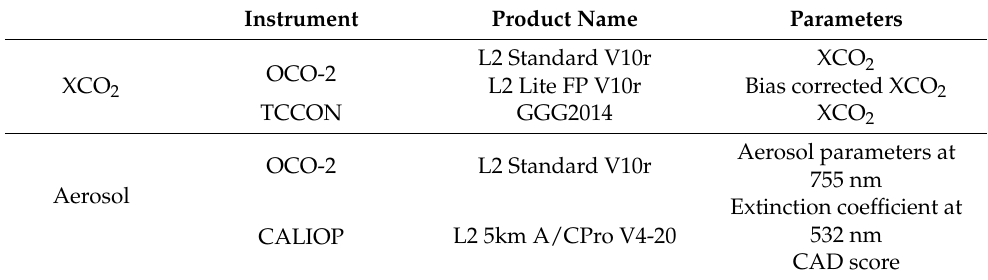
Table 2. Datasets used for the correlation analysis between XCO 2 bias and aerosol scattering effect.